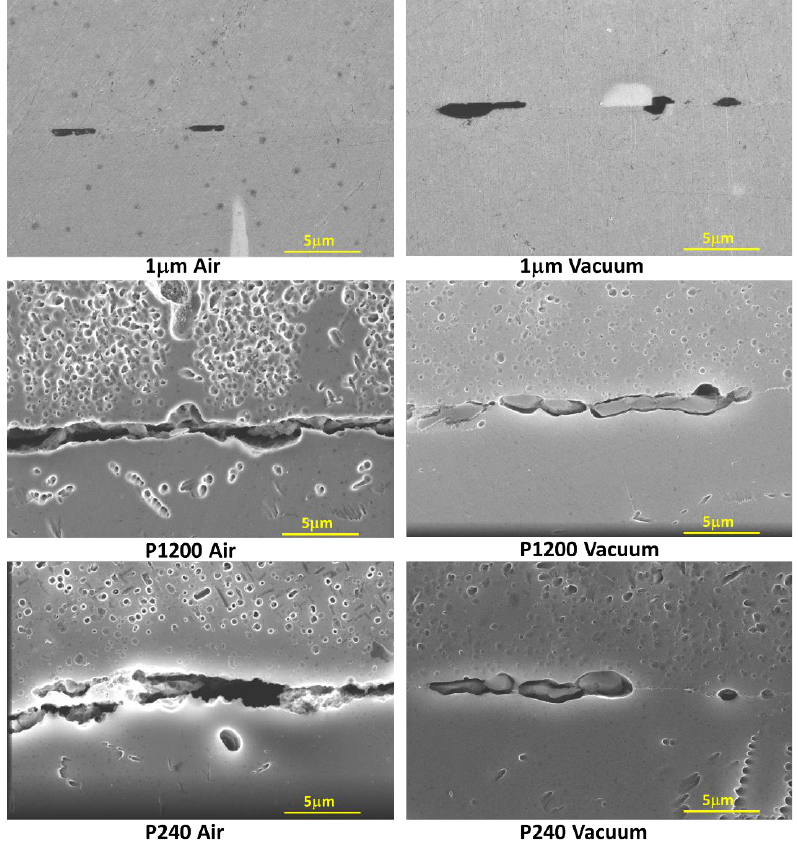
Figure 21. HRSEM microscopic characterization of the interface after DB of AA6061–AA1050 couples with different surface roughness in a vacuum and air oven.